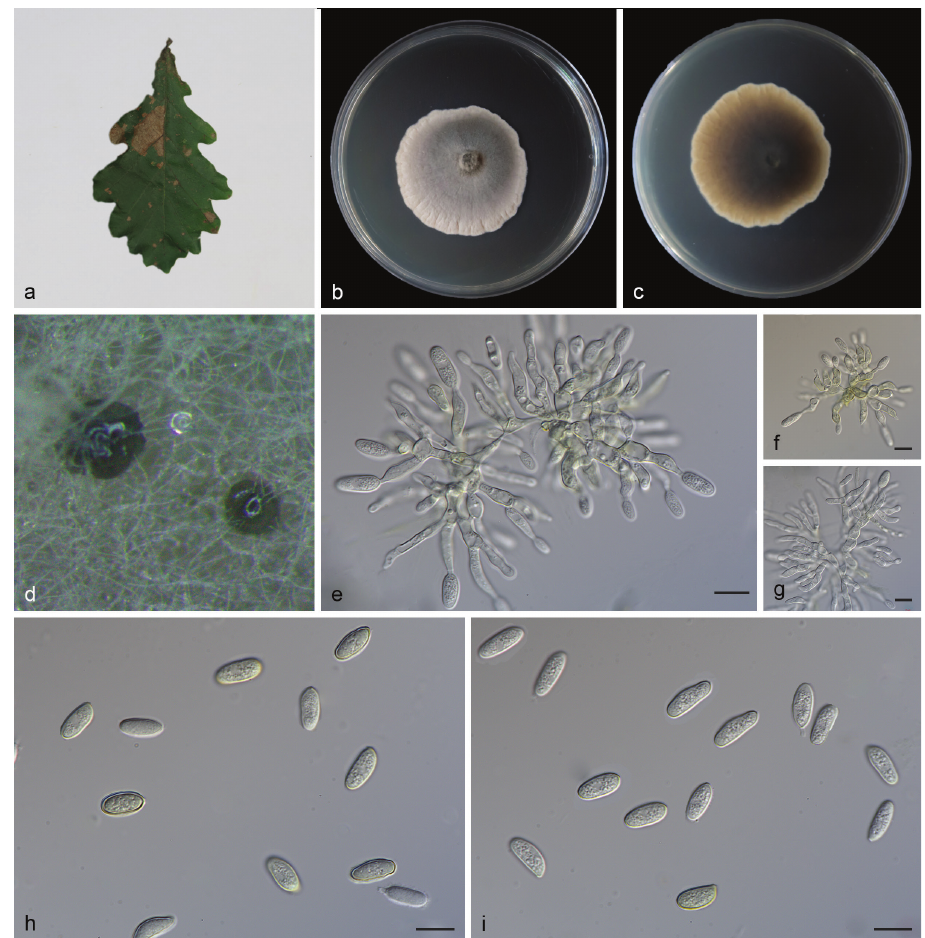
Figure 5. Tubakia dryinoides (SAUCC 1924). a diseased leaf of Quercus palustris; b surface of colony after 15 days on MEA; c reverse of colony after 15 days on MEA; d conidiomata; e–g conidiophores, conidiogenous cells with conidia; h–i conidia. Scale bars: 10 μm ( e–i